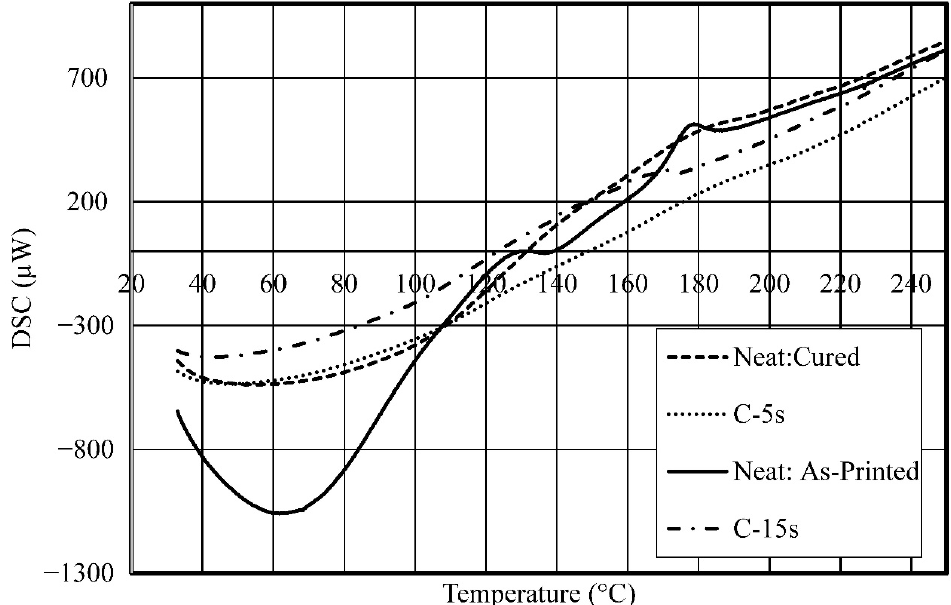
Figure 9. Thermal curing profiles via differential scanning calorimetry (DSC) of as-printed and cured versus carbonated samples.